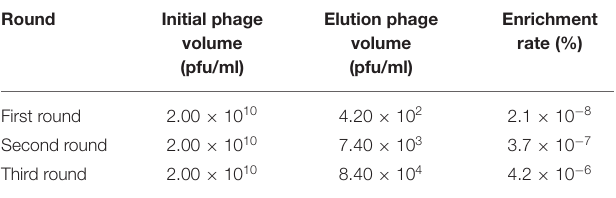
TABLE 1 | Results of three rounds of phage screening in MDA-MB-231 breast cancer stem cells.